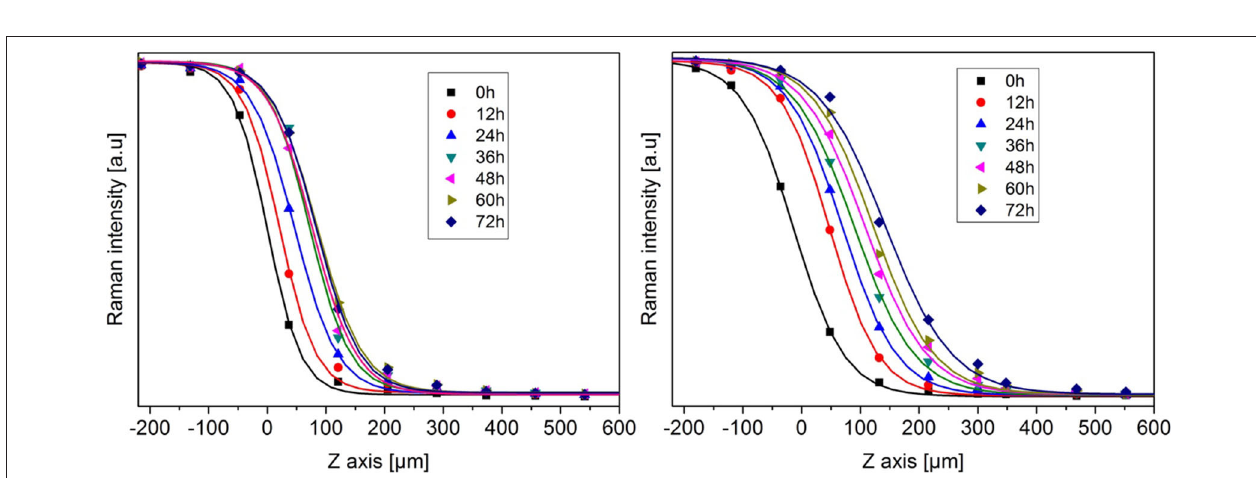
FIGURE 2 | Left : H 2 (black) and OH (red) Raman integrated intensity profiles (normalized) of the THF-HClO 4 -H 2 hydrate at t = 0h, 200 bar and 270K. Negative Z values corresponds at the gaseous phase within the high-pressure optical cell, while positive Z values corresponds to the hydrate phase. Right : H 2 Raman intensity profiles of the THF-HClO 4 -H 2 hydrate at 0h (black) and after 12h (red) of 200 bar H 2 pressure.